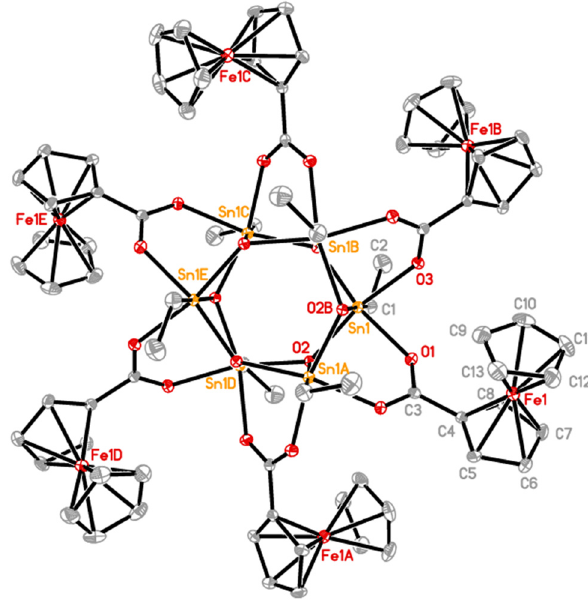
Figure 3: The molecular structure of 3 . Ellipsoids are drawn at the 20% probability level. Hydrogen atoms are omitted for clarity.